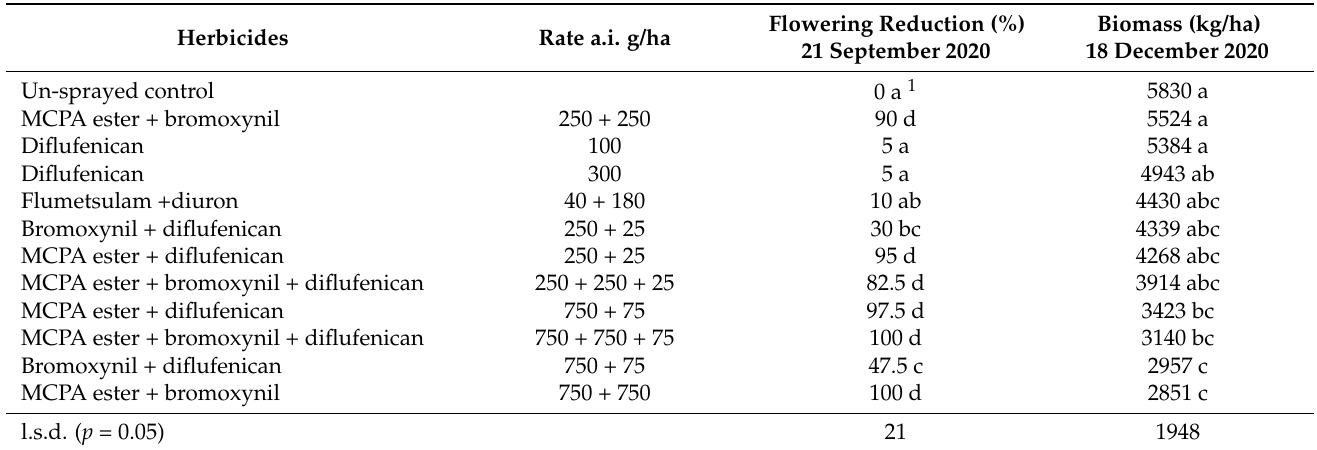
Table 11. Effect of herbicides on tedera flowering three weeks after application (21 September 2020) and biomass production 15 weeks after application (18 December